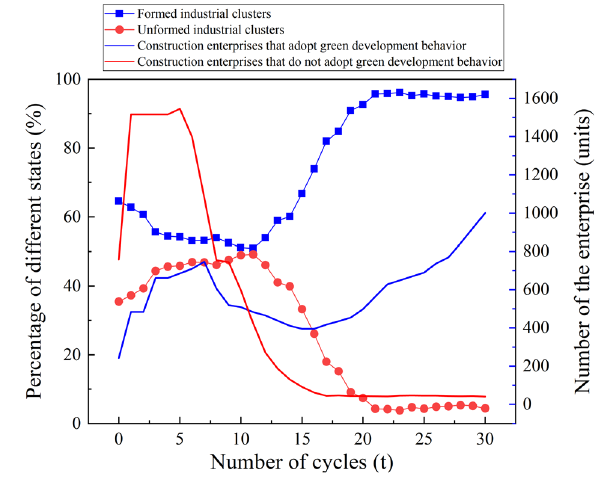
Fig. 8 The process of the in fl uence of industrial clusters on the scale of the green development behaviors adopted by construction enterprises. It shows the impact of industrial clusters on the green development behaviors of construction enterprises and the external environment from two aspects: the proportion of construction enterprises that adopt different behaviors and the generation of renewable construction